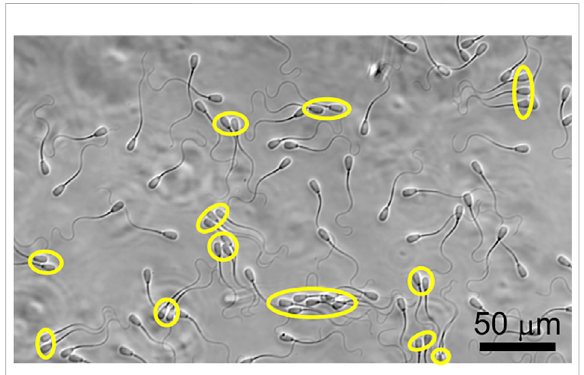
FIGURE 1 Coexistence of individually swimming and clustered sperm. Clustered sperm are labeled with yellow